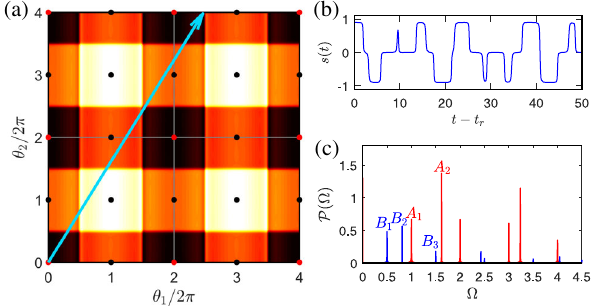
FIG. 5. Z 2 × Z 2 DTQC with the model and observables de- tailed in Appendix D 1. (a) Observable s ð θ Þ in θ space at leading order in inverse frequency, displaying the symmetry-breaking (red points) as well as the original lattice of pattern lattice L SSB translations L (black points). Grey boxes denote the symmetry- breaking unit cell. (b) Discrete time quasicrystal response s ð t Þ ¼ s ð ω t Þ . (c) Power spectra P ð Ω Þ of both the driving function (red) and the observable s ð t Þ (blue). Dominant peaks in the driving function correspond to Ω ¼ ω 1 ( A 1 ) and Ω ¼ ω 2 ( A 2 ). Dominant peaks of the observable s ð t Þ correspond to Ω ¼ ω 1 = 2 ( B 1 ), Ω ¼ ω 2 = 2 ( B 2 ), Ω ¼ 3 ω 1 = 2 ( B 3 ). Going beyond leading order in inverse frequency, an observable ’ s power spectrum can n · ω for n ∈ Z 2 exhibit peaks at the frequencies Ω ¼ 1 2